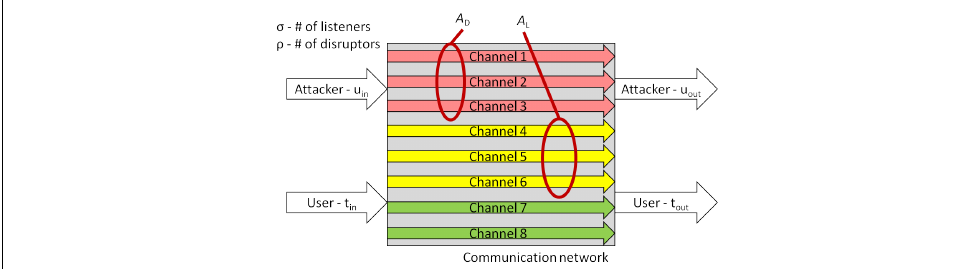
Figure 1. A Network Configuration with Multiple Logical